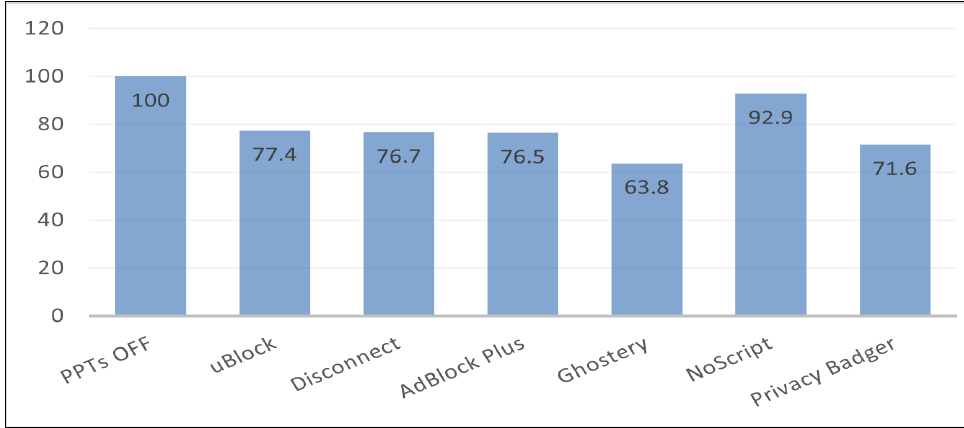
Figure 7. The average page load time, or PLT.